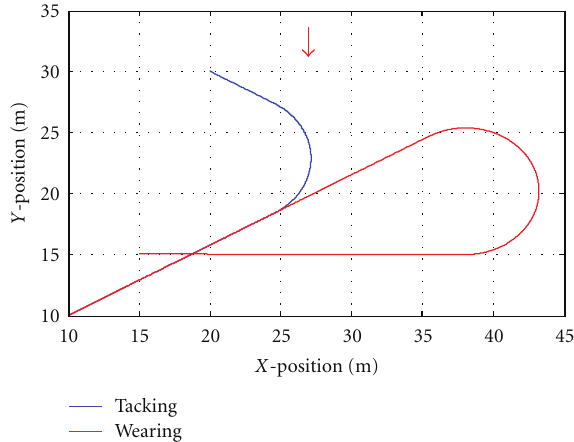
Figure 6: Trajectories followed by the vehicle with red arrow indicating where the wind comes